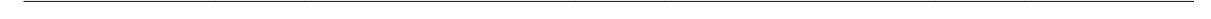
Fig. 3. Teeth of Tamiobatis from the Devonian and Carboniferous of Belarus. A – L , Tamiobatis elgae Ivanov sp. nov. A–J, GIT 783-1, holotype; Turov-106 core, depth 207 m, sample 2b, Lower Tournaisian, Malevka Regional Stage. A–L, SEM images; A–C, occlusal (B, C – details of crown), D, oblique lateral, E, lingual, F, labial and G, basal views. H–J, microtomographic images; H, virtual sagittal section of tooth, I, virtual frontal section of tooth base, J, lingual view in transparent mode. K , L , PM SPU 82-5, occlusal view (L – detail of crown), 506 core, depth 241.6 m, sample 56b, Upper Famennian, Borovoe Regional Stage. M – P , Tamiobatis sp. M–O, 506 core, depth 241.6 m, sample 56b, Upper Famennian, Borovoe Regional Stage. M, PM SPU 82-6, oblique labial view; N, O, PM SPU 82-7, N, occlusal and O, labio-basal views; P, PM SPU 82-8, oblique labial view, 331 core, depth 276–277 m, sample 12, Lower Tournaisian, Upa Regional Stage. Abbreviations: ac, ascending canal; lc, longitudinal canal; mhc, main horizontal canal; pc, pulp canal; shc, secondary horizontal canal. Scale bars 500 µm, besides M, N – 250